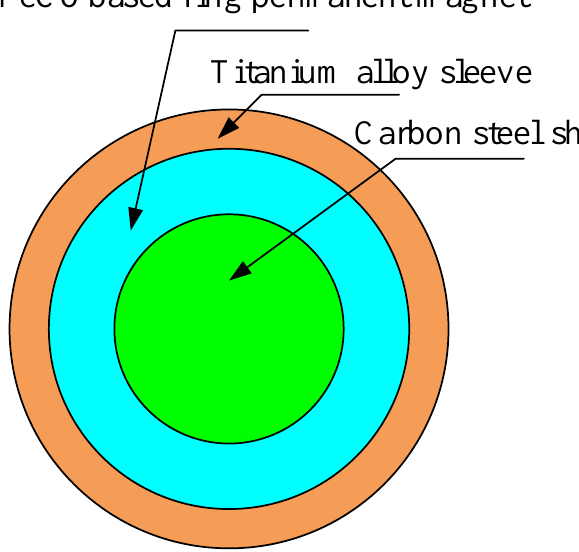
Figure 1. Rotor structure of HSPMM. Table 1. Rotor material performance parameters. The rotating shaft, FeCo-based PM, and titanium alloy sleeve of HSPMM are circular. According to the classical thick wall cylinder theory, the strength of FeCo-based PM rotor is analyzed and calculated, the outer radius of rotor core is set as R or , and the inner and outer radius of PM are R im and R om . The inner and outer radius of titanium alloy sleeve are R it and R ot , the rotor dimension is shown in Figure 2a, and the interference between PM and titanium alloy sleeve is δ . PM is in binding contact with the rotor core, and the interference is 0.